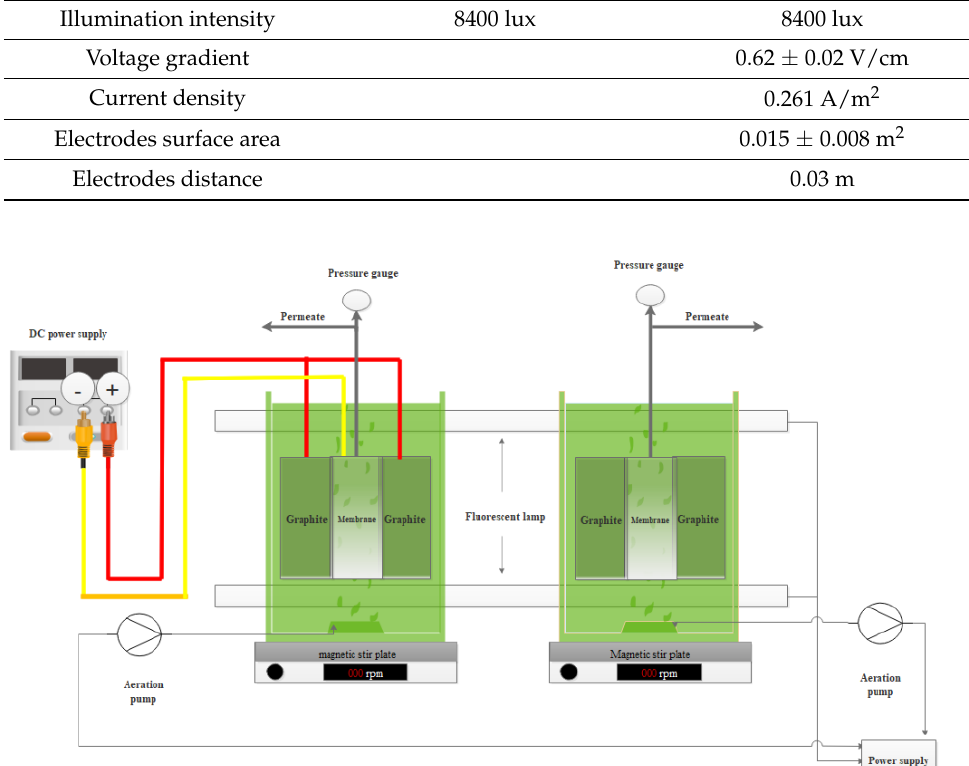
Figure 1. Schematic of lab-scale MPBR and EK-MPBR set-up. Table 2. Specification of the membrane module and operating condition.